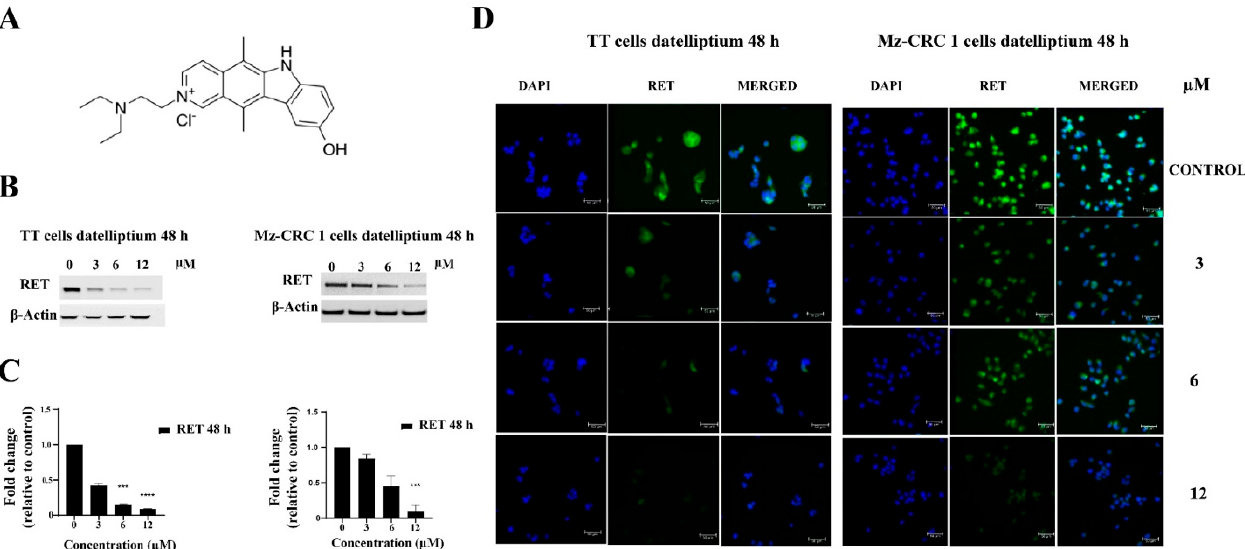
Figure 1. The antitumor activity of datelliptium on RET expression. ( A ) Structure of datelliptium, ( B ) Western blot analysis of the expression of RET in TT and MZ-CRC-1 cells treated with datelliptium for 48 h. ( C ) Densitometry analysis of the western blotting results for RET was normalized to its basal expression ( n = 3, **** p < 0.0001, and *** p < 0.001) using one-way ANOVA with Tukey post-test. ( D ) Immunofluorescence staining of the expression of RET in TT and MZ-CRC-1 cells treated with datelliptium for 48 h (×400, scale = 50 μ m); DAPI (blue stained nuclei).